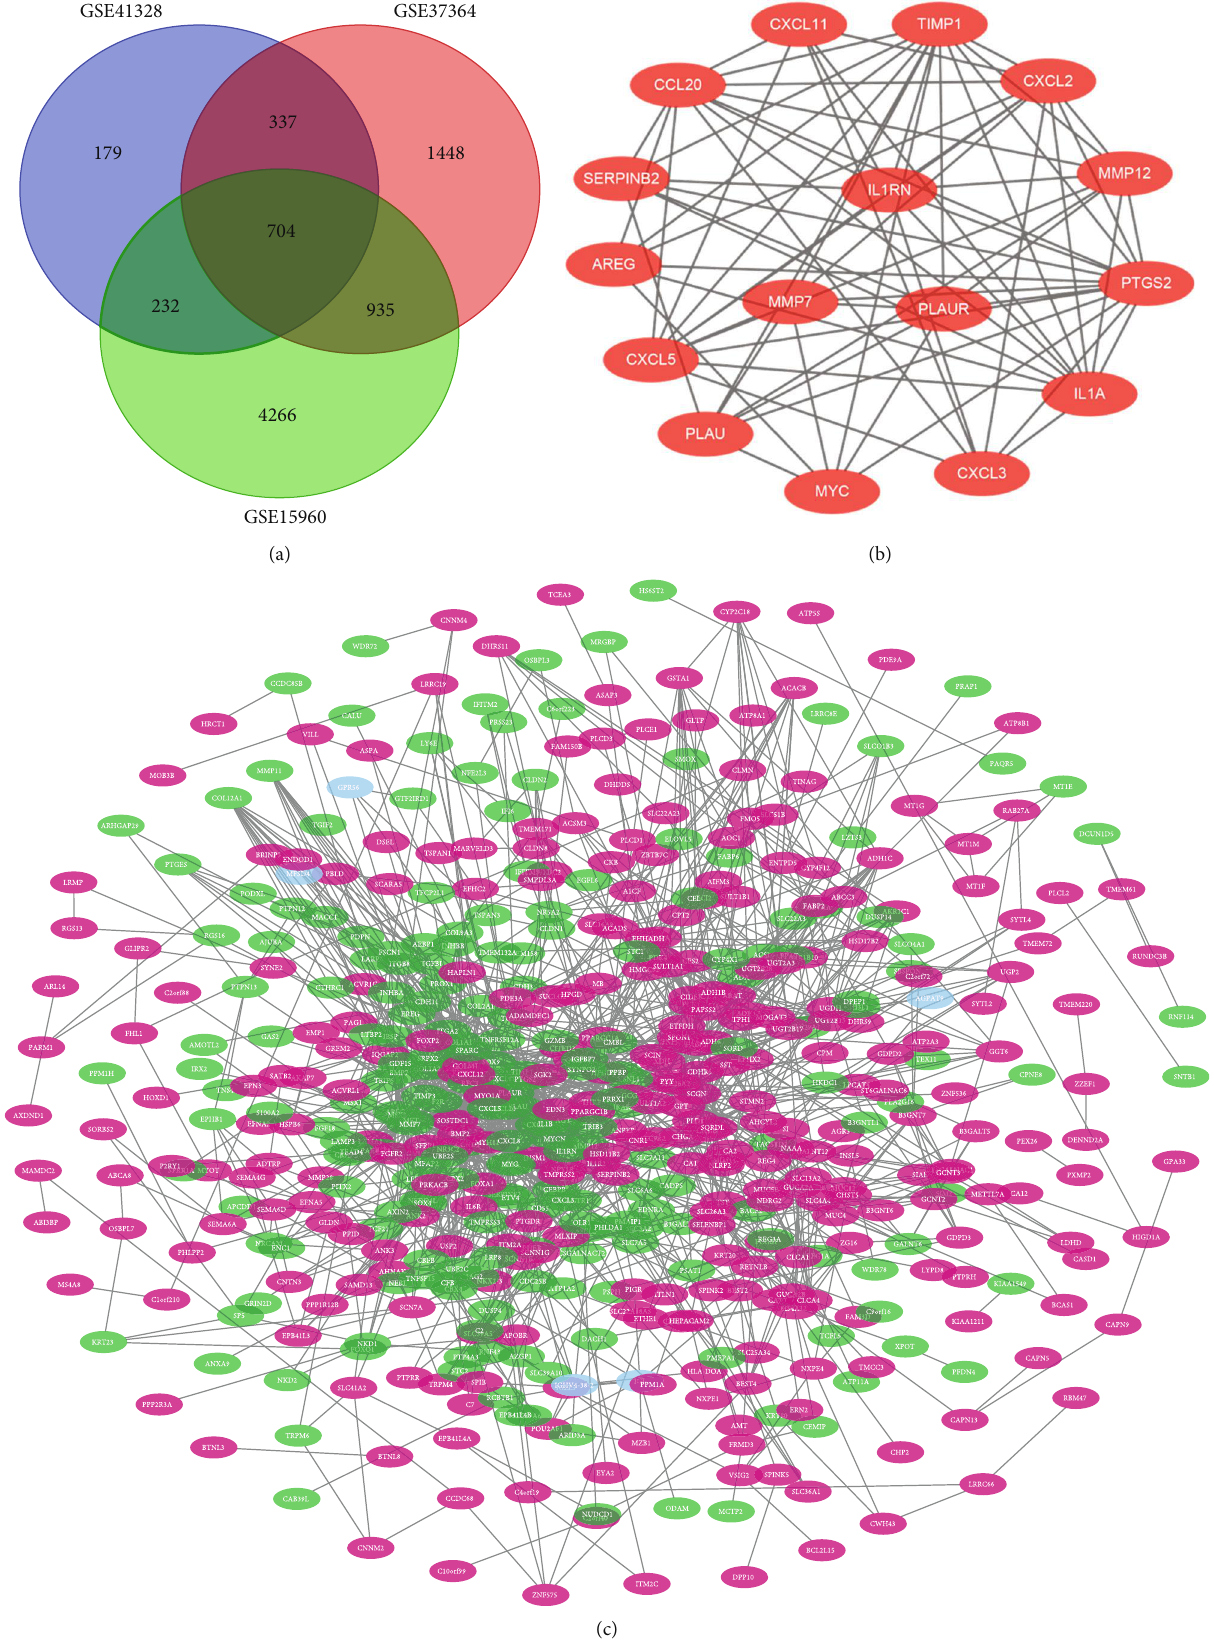
Figure 1: Venn diagram, PPI network, and module of IL1RN. (a) DEGs were selected with a fold change > 1 and P < 0 : 01 among the mRNA expression pro fi ling sets GSE41328, GSE37364, and GSE15960. (b) The PPI network of DEGs was constructed using Cytoscape. (c) The most module of IL1RN was obtained from PPI network with 33